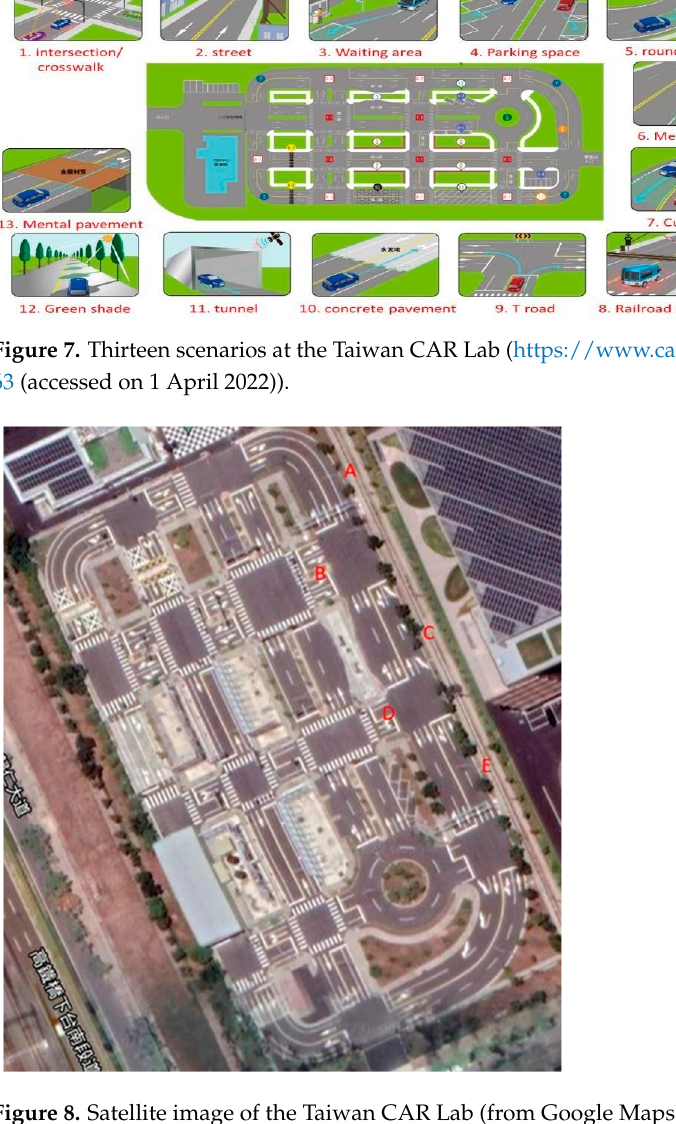
Figure 8. Satellite image of the Taiwan CAR Lab (from Google Maps). The parts marked in red are the road sections that were chosen for testing to generate data. “A” is a corner section, and the other parts are straight roads with different numbers and directions of lanes. The non-English fonts are the description of Taiwan High Speed